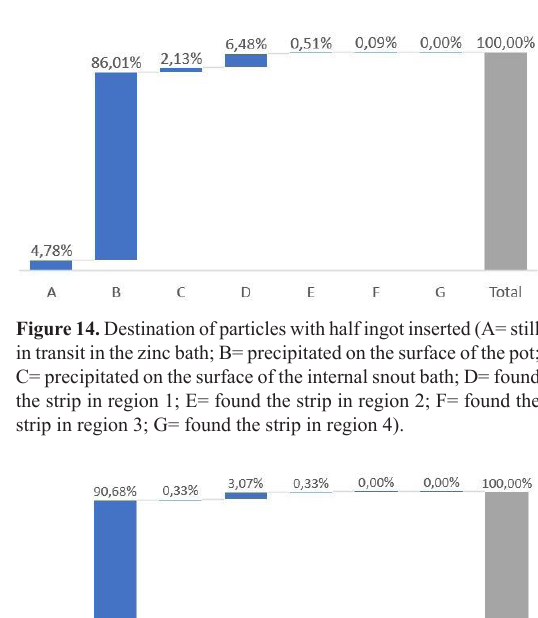
Figure 13. Destination of particles with ingot completely inserted (A= still in transit in the zinc bath; B= precipitated on the surface of the pot; C= precipitated on the surface of the internal snout bath; D= found the strip in region 1; E= found the strip in region 2; F= found the strip in region 3; G= found the strip in region 4).